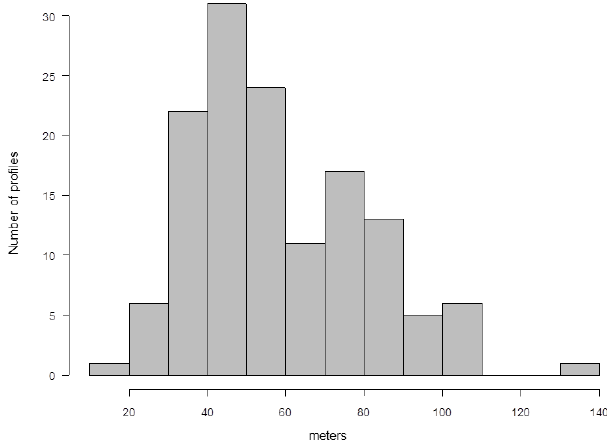
Figure 8. Depth distribution of chl a maxima exceeding 30% of the surface values.